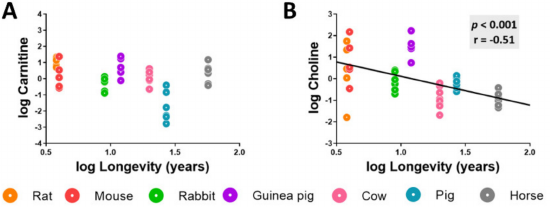
Figure 5. Heart choline concentration negatively correlates with mammalian longevity. Individual heart concentration of the lipid intermediates choline ( A ) and carnitine ( B ) are reported in log(MS counts/g tissue). Pearson correlation between the heart carnitine and choline lipid metabolites and animal longevity was performed. Minimum significance level was set at p < 0.05. All values were log-transformed in order to accomplish the assumptions of